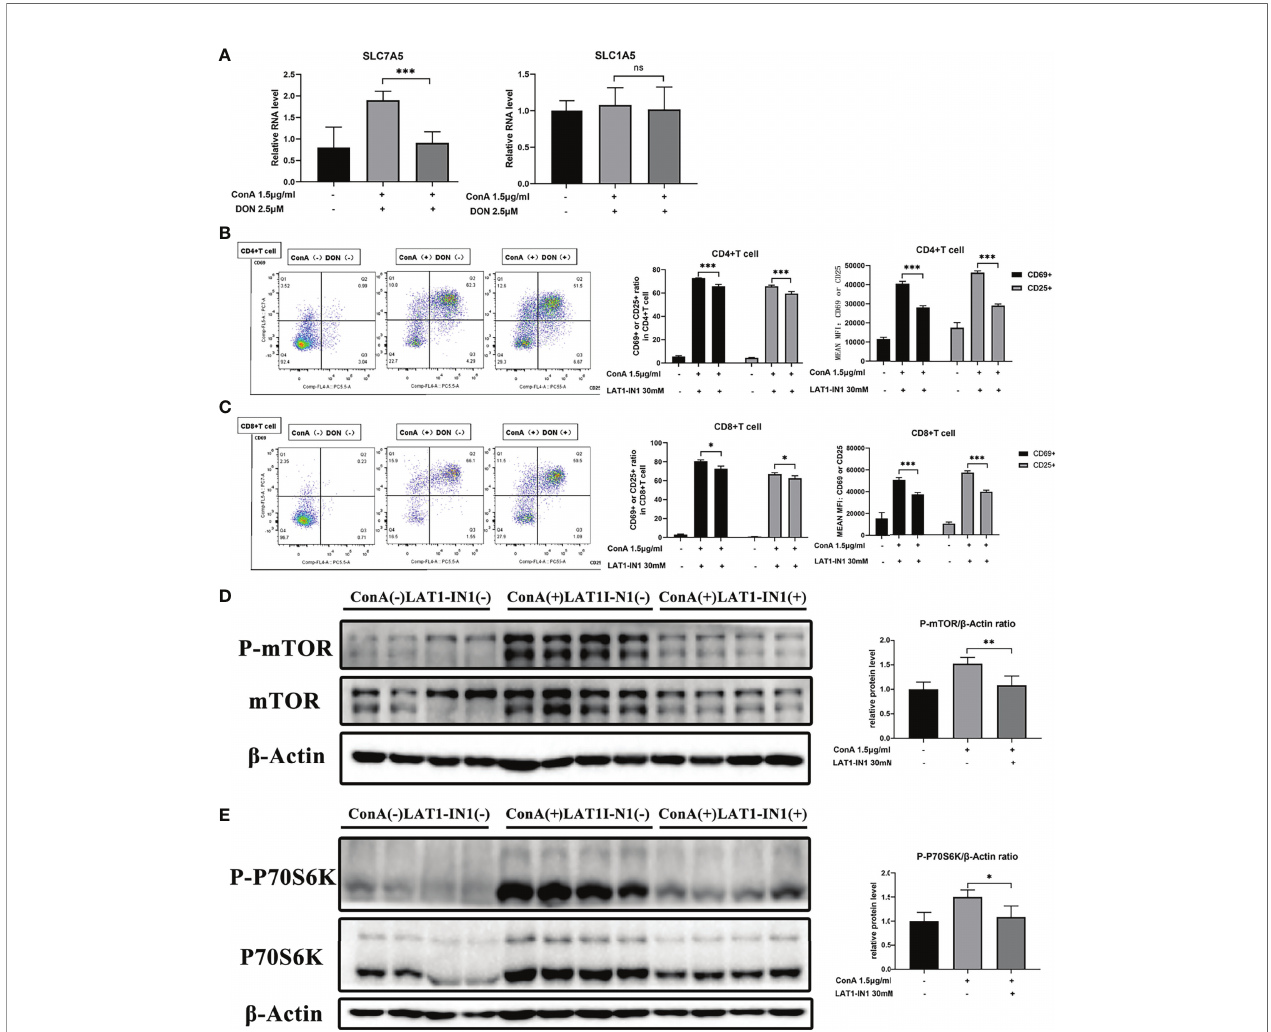
FIGURE 7 | The function of DON to mTOR signaling may be mediated by amino transporter amino transporter SLC7A5. (A) qRT-PCR was applied to analyze amino acid transporters SLC7A5 and SLC1A5 mRNA levels. (B, C) Flow cytometry was applied to analyze the degree of activation (expression of CD25 and CD69) of CD4 (+) (B) and CD8(+) (C) T cells with or without treating LAT1-IN1. The levels of phosphorylated mTOR (D) as well as phosphorylated P70S6K (E) were examined by western blotting. Data were expressed as means ± SEM. *P < 0.05, **P <0.01, and ***P <0.001. ns, not signi fi